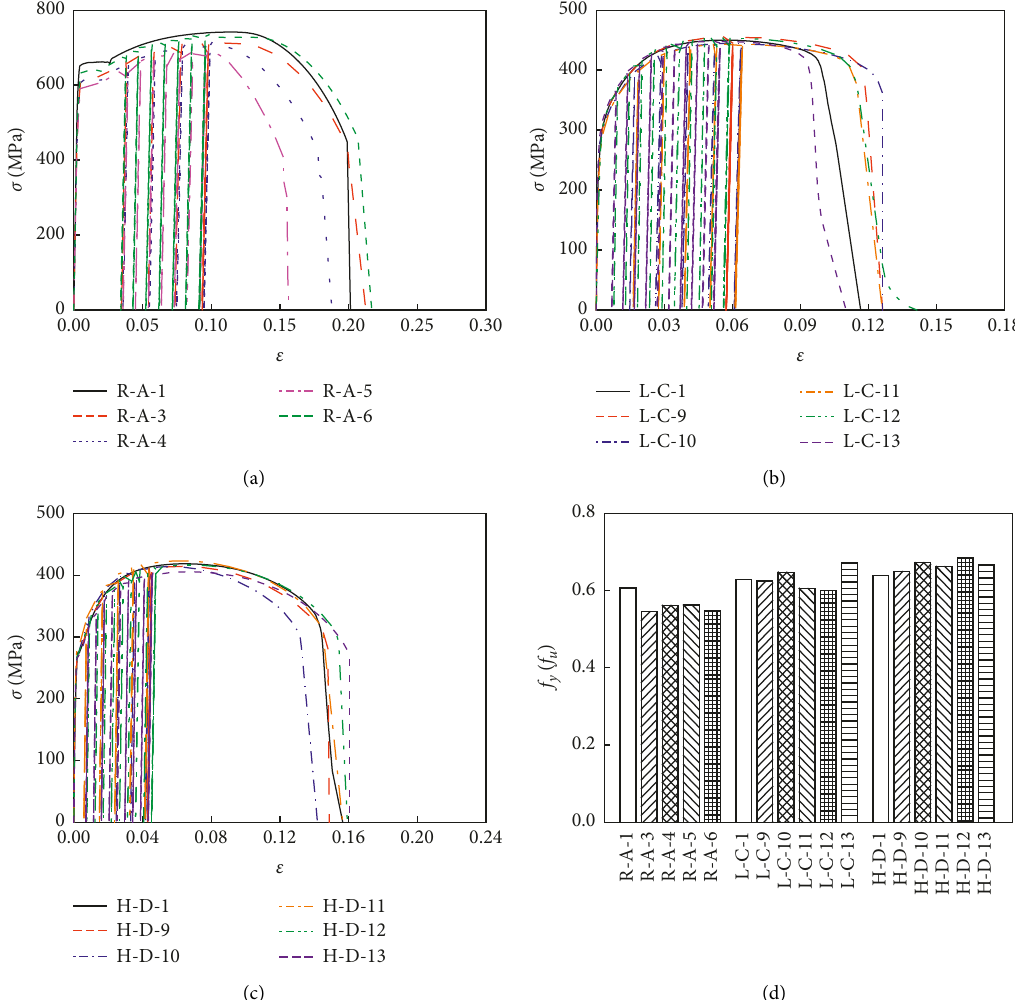
Figure 7: Effect of different loading patterns on stress-strain curves of specimens. (a) Specimens of group R-A. (b) Specimens of group L-C. (c) Specimens of group H-D. (d) The ratio of yield strength to ultimate tensile strength of three sets of specimens in different loading modes: R-A, L-C, and